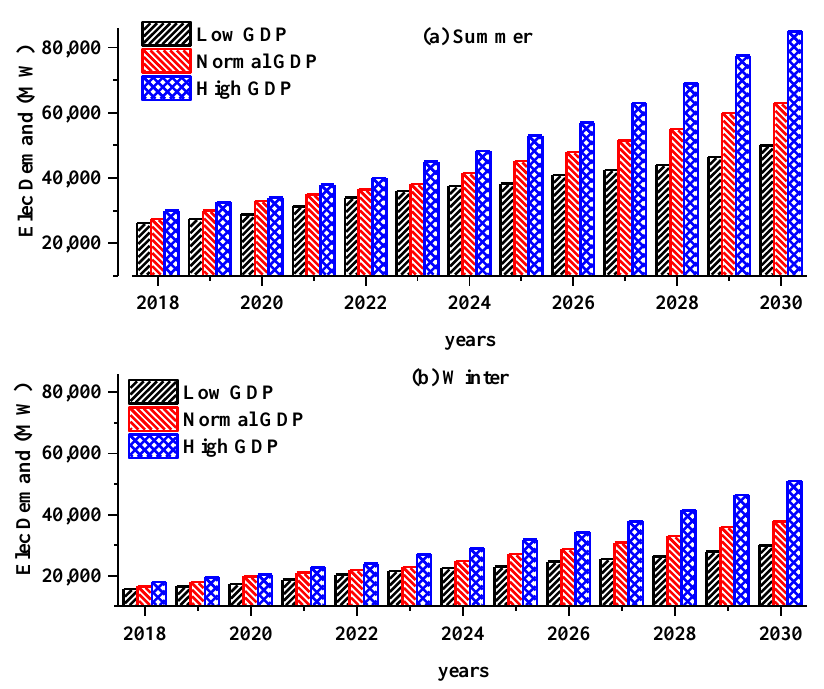
Figure 4. Electricity demand of Pakistan. ( a ) Summer. ( b )